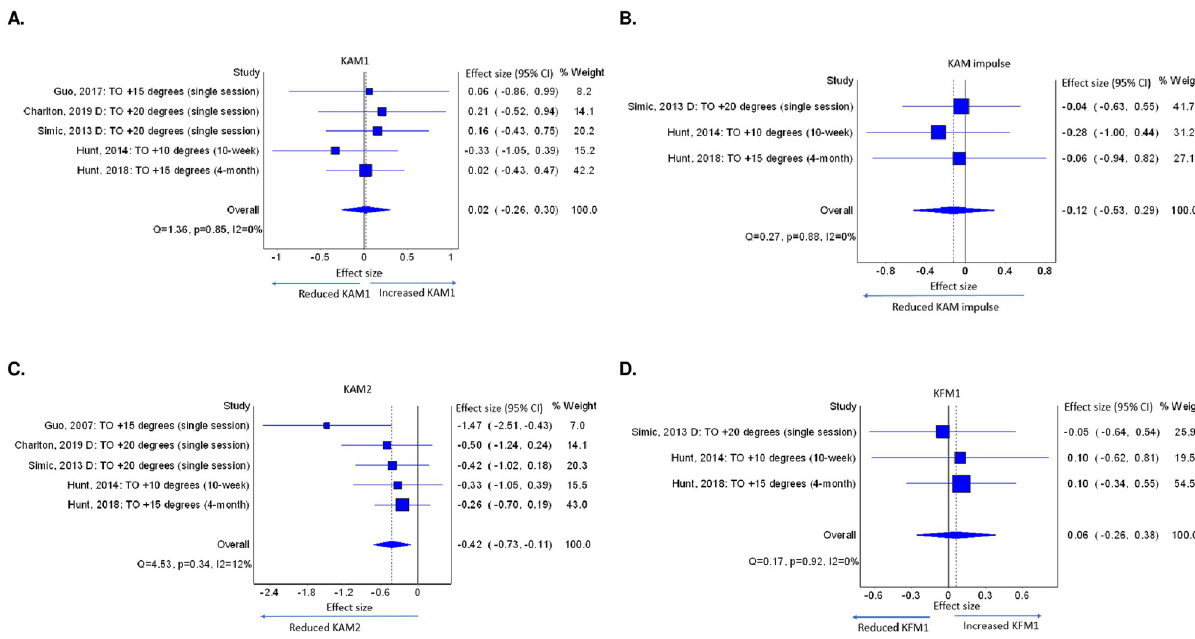
Fig 3. A. Effects of toe-out on KAM1, B. KAM impulse, C. KAM2, D. KFM1 (TO: Toe-out; KAM1: early stance phase peak external knee adduction moment, KAM impulse: external knee adduction moment impulse, KAM2: late stance phase peak external knee adduction moment, KFM1: early stance phase peak external knee flexion